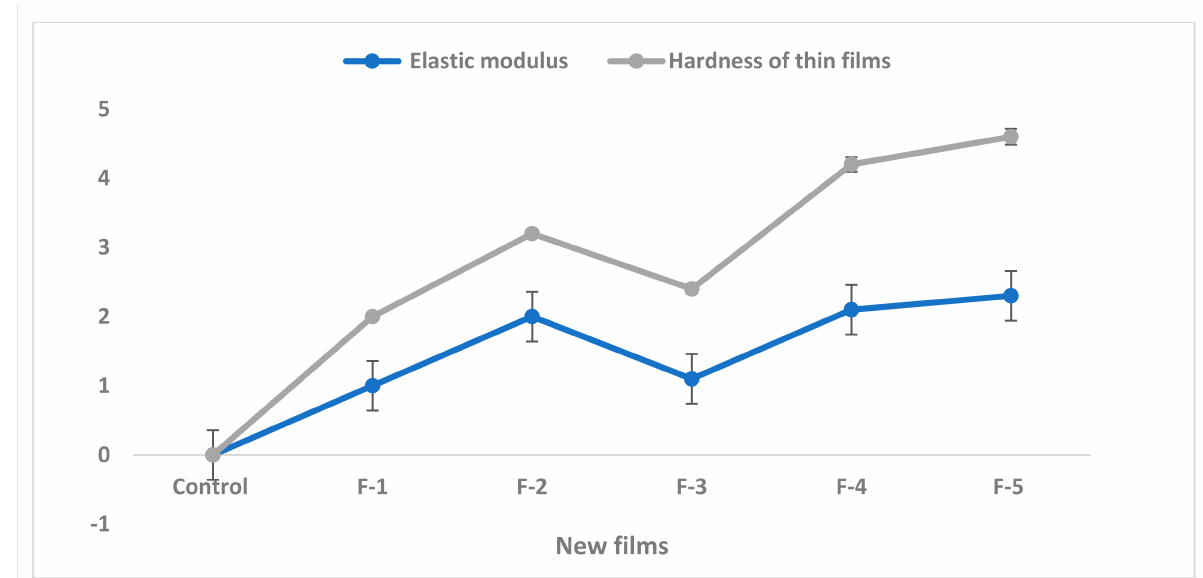
Figure 4. Elasticmodulus and hardness of new